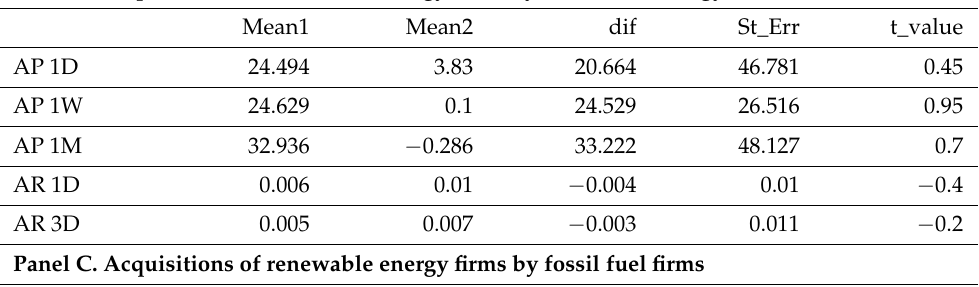
Table 7. Acquisition premia and post-completion returns—cross-sectional univariate comparison.